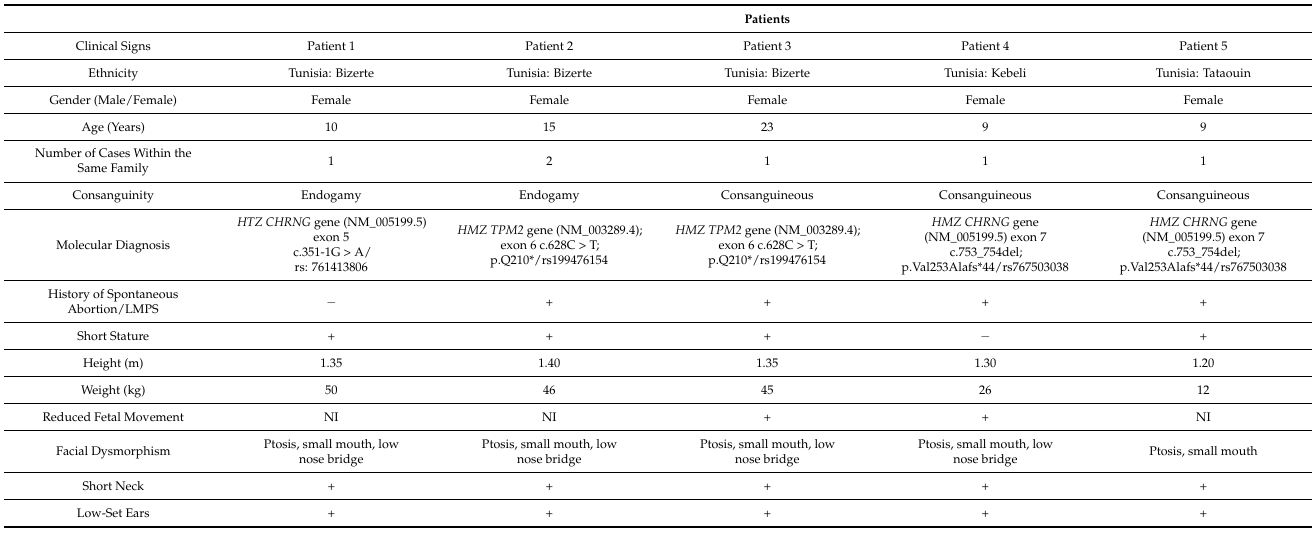
Table 2. Clinical and radiological features of our patients with Escobar